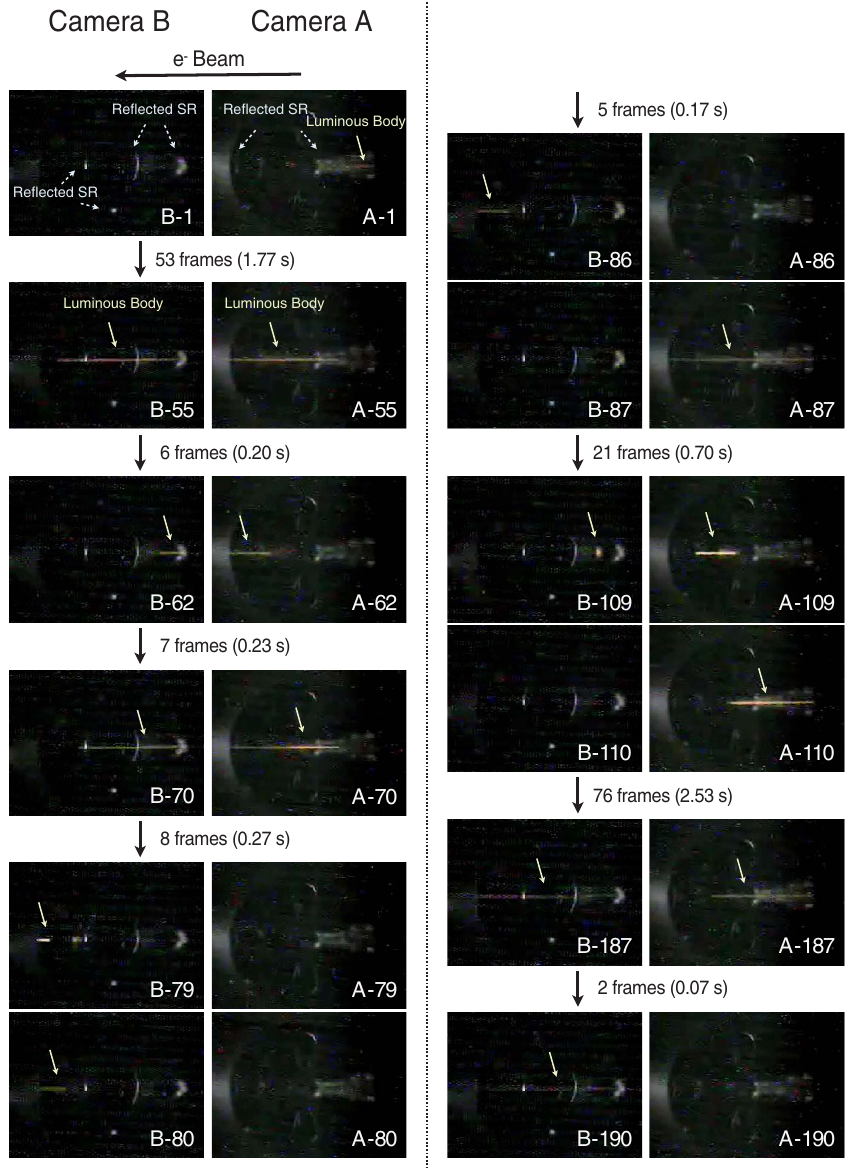
FIG. 11. (Color) Frame-by-frame images selected from the recorded movies. The luminous bodies observed during the experiment are indicated by the